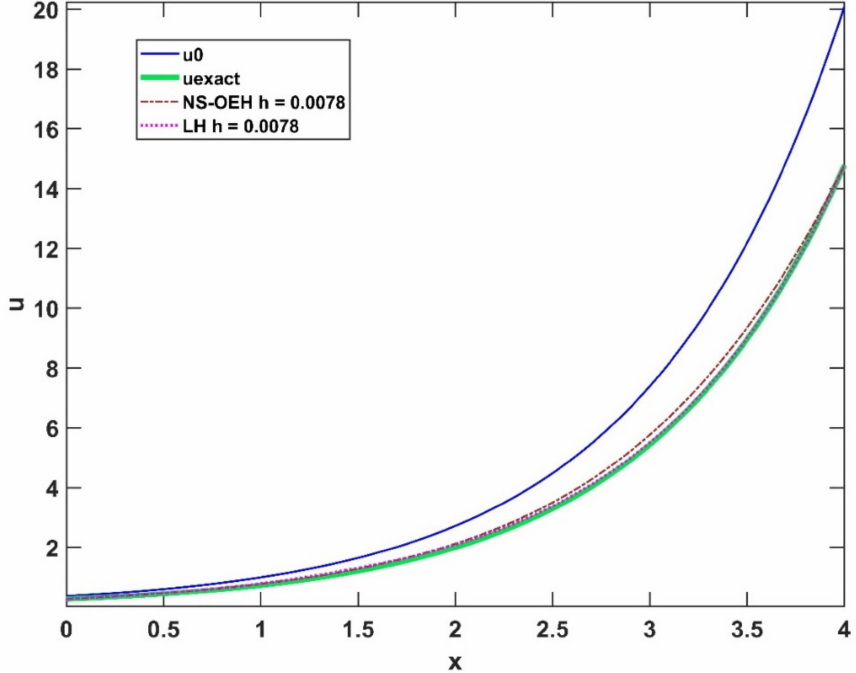
Figure 3. The temperature values as a function of the x variable in the case of the initial function u 0 , the analytical solution at t fin = 2, the NS-OEH method and the LH method for ∆ t = 7.8 · 10 − 3